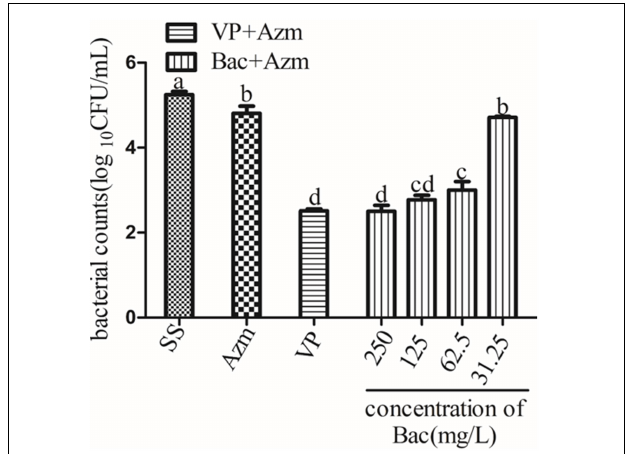
FIGURE 7 | Viable bacterial counts of 48 h biofilms after exposure to agents for 24 h. Biofilms were formed on slices for 48 h by growing ARSS in BHI and then treated with Azm alone or in combination with 250, 125, 62.5, and 31.25 mg/L baicalin and 250 mg/L verapamil for 24 h. Bars in the same index without the same letters differ significantly ( p <